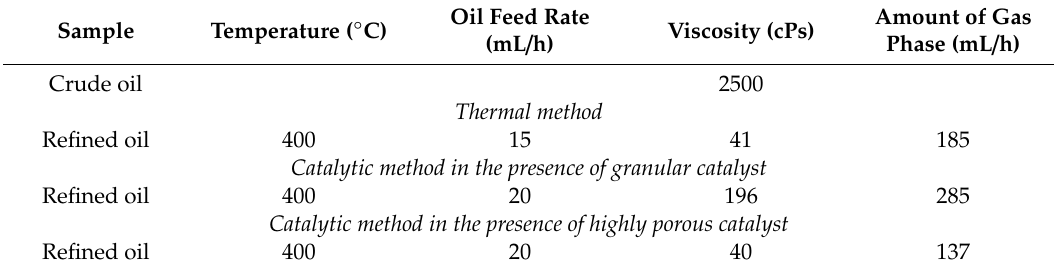
Table 3. Performance features of non-catalytic and catalytic processes for the oil viscosity decrease.